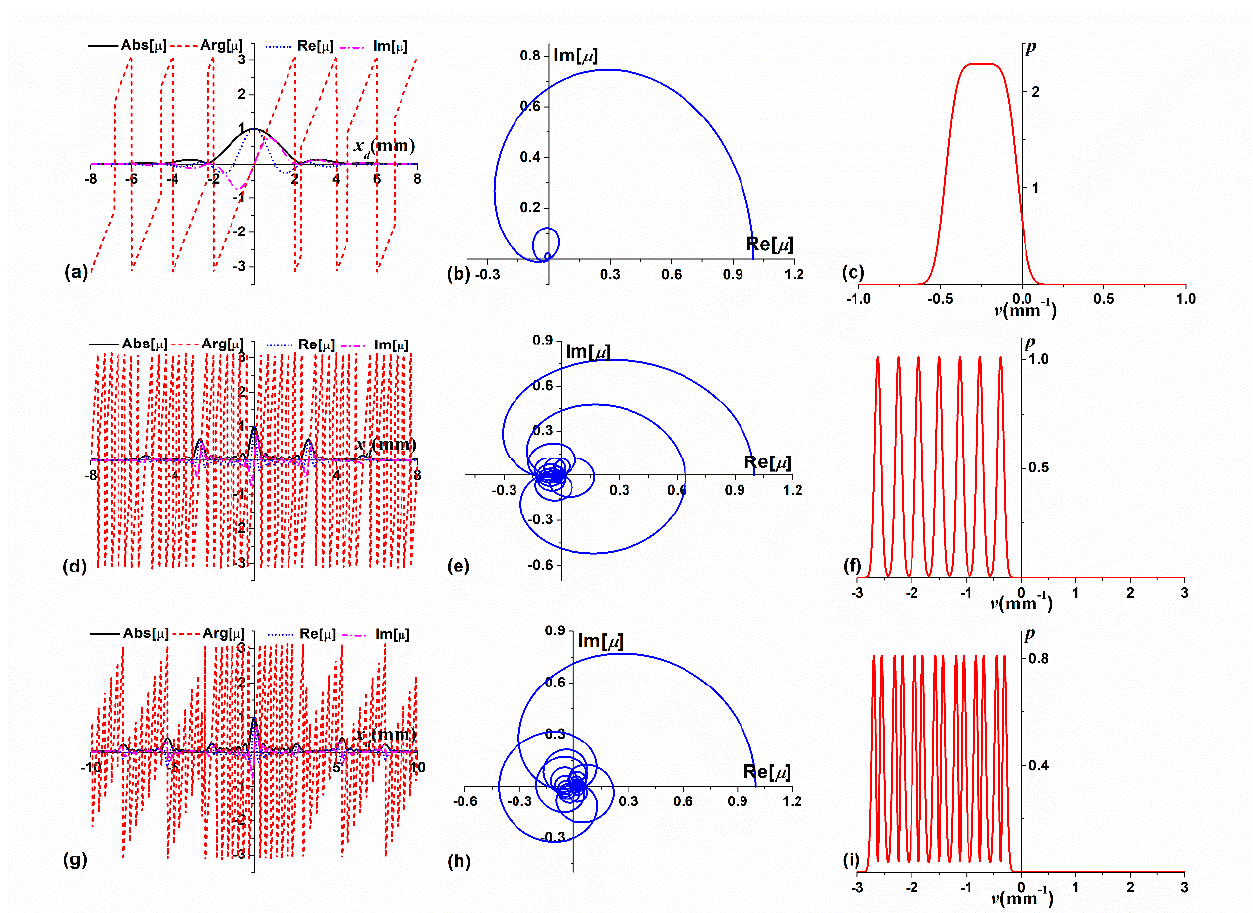
Figure 4. The source coherence states calculated from Equation (22) and the far-field spectral densities calculated from Equation (23) for different values of the source parameters δ t and L . ( a – c ) δ α = δ β = 2mm, L = π /8; ( d – f ) δ α = δ β = 2mm, L = 3 π /4; ( g – i ) δ α = 2mm, δ β = 2.5mm, L = 3 π